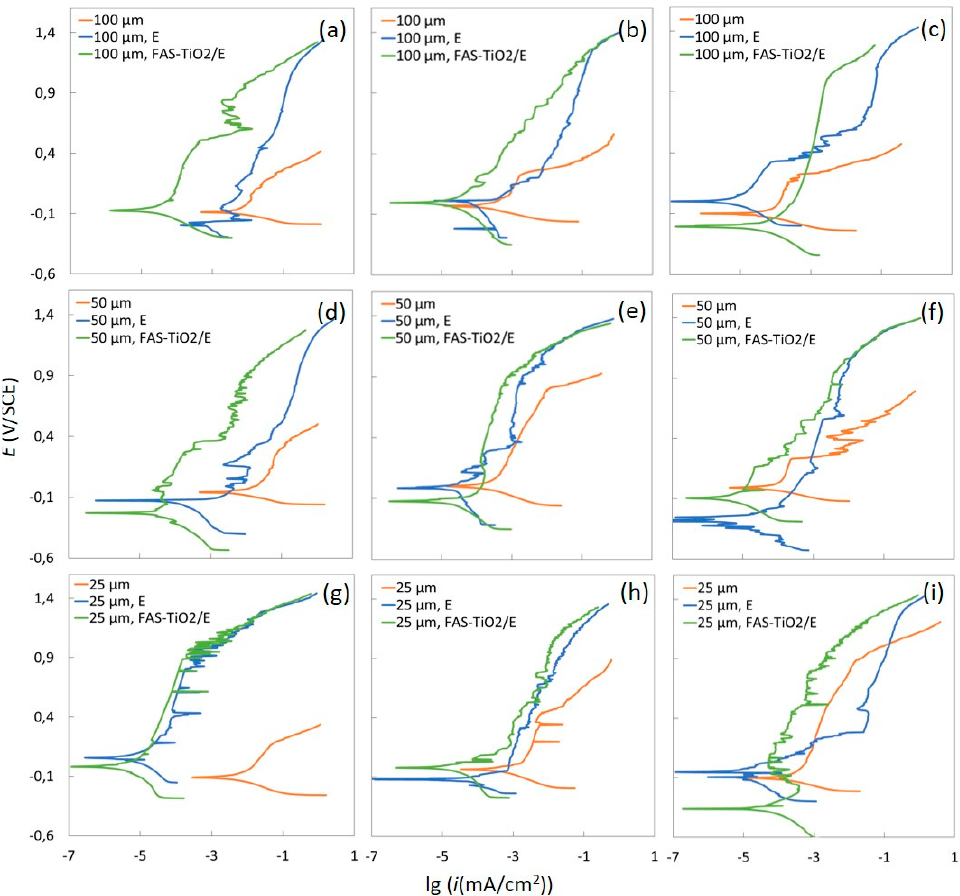
Figure 7. Potentiodynamic curves for uncoated, epoxy-coated, and FAS-TiO 2 /epoxy-coated laser-textured stainless steel with different scan line separations ( ∆ x = ∆ y = 100, 50, 25 μ m) in a simulated physiological Hank´s solution measured ( a , d , g ) immediately after laser-texturing, ( b , e , h ) after 3 months, and ( c , f , i ) after 1 year storage in ambient conditions.